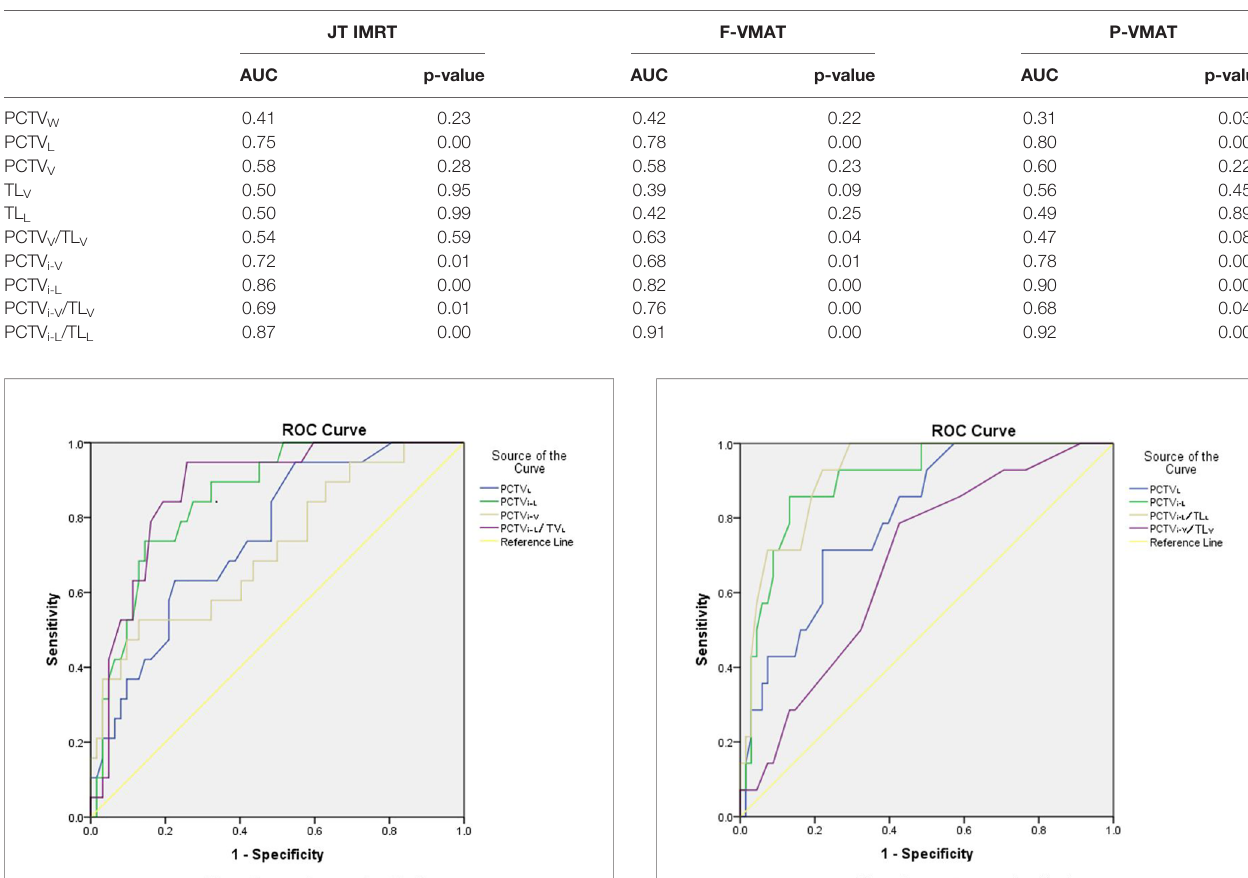
TABLE 3 | Results of receiver operating curve (ROC) analysis.